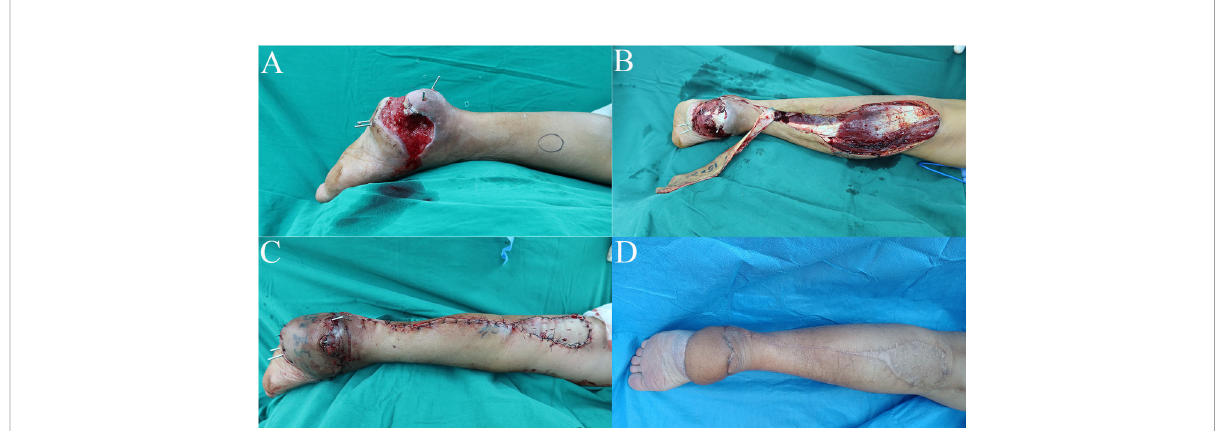
FIGURE 1 Case 1: Te distally based sural neurocutaneous fl aps for reconstruction of the heel soft tissue defect. (A) Diabetic wound at the heel. (B) Harvest of the distally based sural neurocutaneous fl ap. (C) The defect was reconstructed with a fl ap, and the donor site was covered with skin graft. (D) The fl ap and the donor site were completely healed at